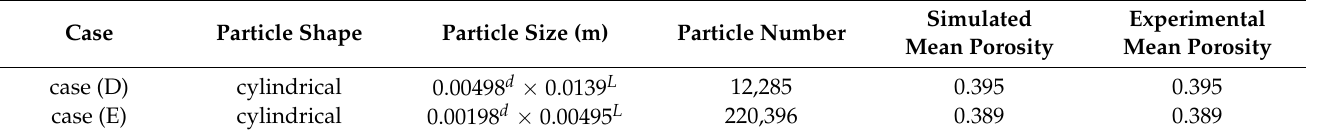
Table 2. Characteristics of cylindrical particle